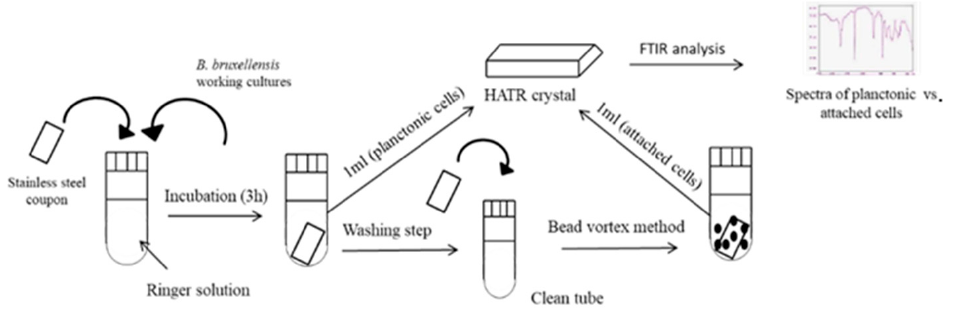
Figure 1. Schematic representation of the main steps implicated in samples preparation for the FTIR analysis. HATR: Horizontal Attenuated Total Reflectance